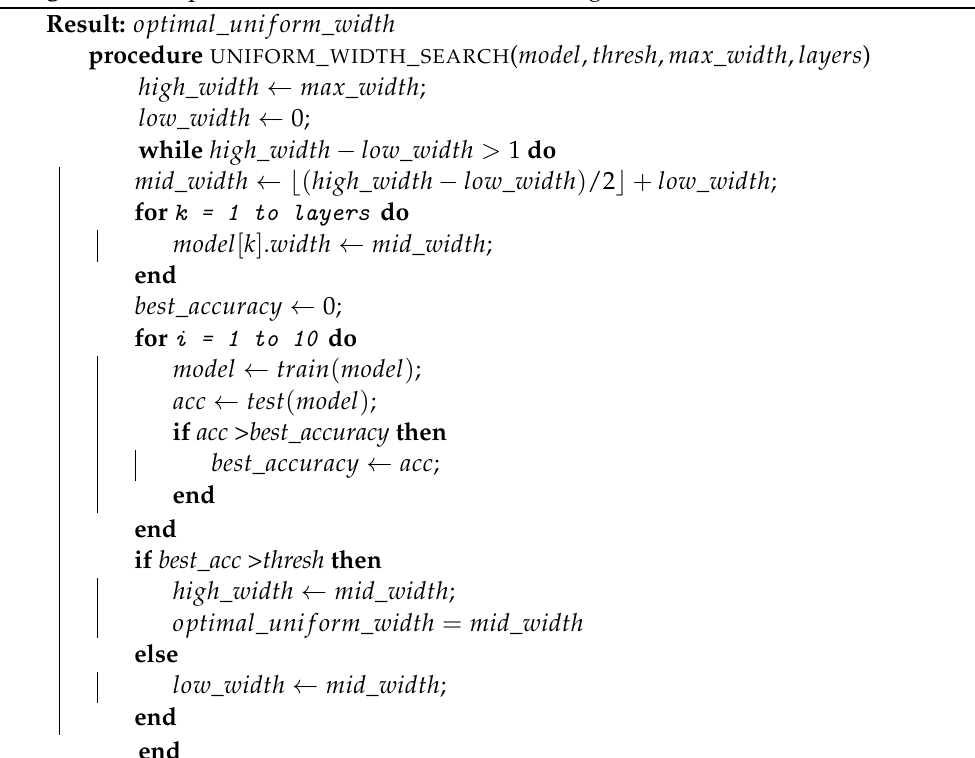
Algorithm 1: Optimal uniform channel search for a given BNN